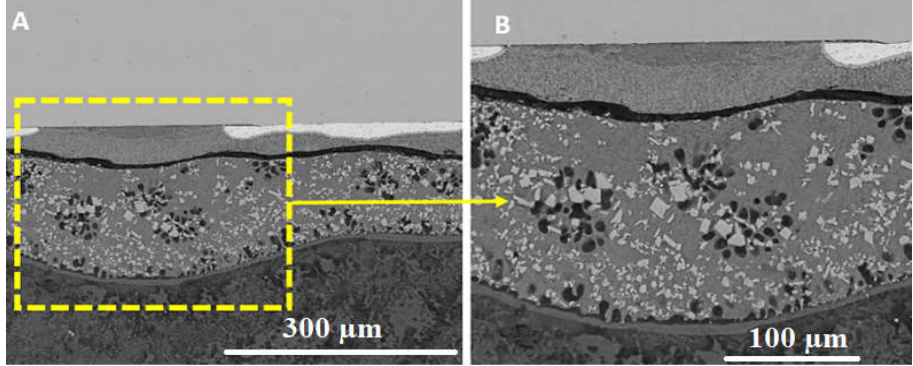
Figure 9. (A) Ti and Mg joint bonded using Ni/Al 2 O 3 interlayer for 60 min at 500 °C (B) Detailed view of the highlighted region.